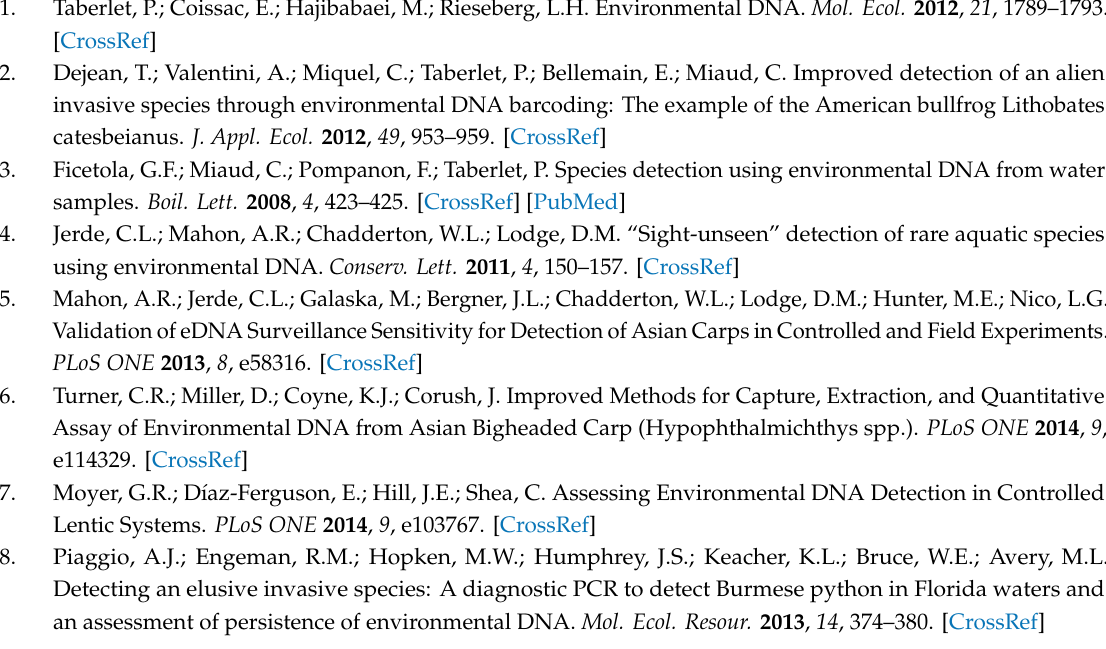
Figure S1: Quantitative PCR amplification of 0.1 ng / µ L concentration tissue extracted snake DNA, Figure S2: Quantitative PCR amplification of C. kirtlandii tissue and feces positives, and eDNA from a crayfish burrow, Figure S3: Cumulative standard curve from all qPCR standards, Table S1: Comparison of primer and probe sequences of the eDNA assay to homologous CO1 sequences acquired from GenBank. Table S2: Correlation matrix of potential predictors of eDNA detection in artificial crayfish